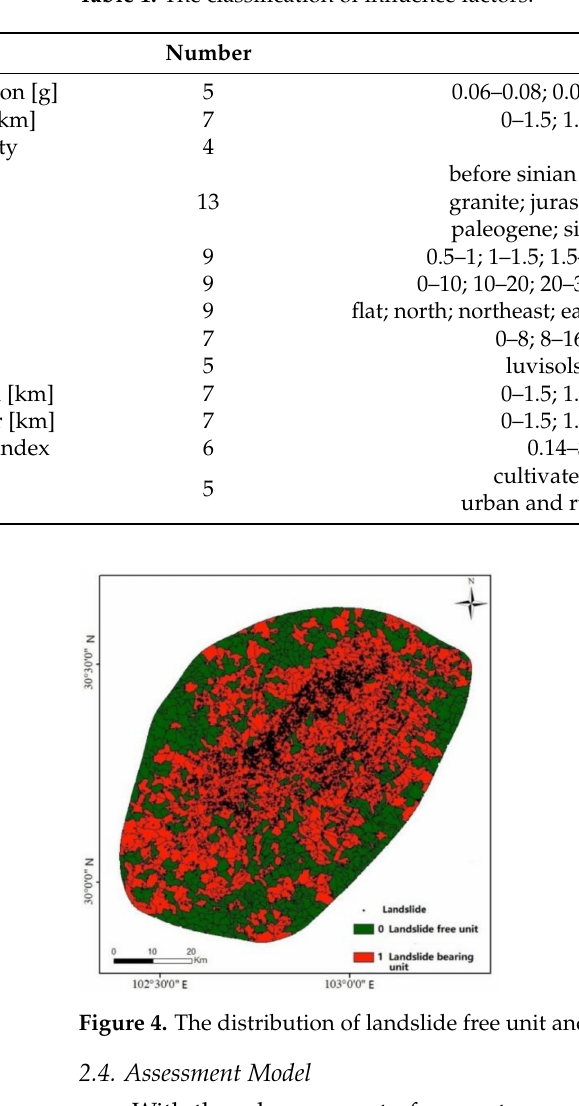
Table 1. The classification of influence factors.